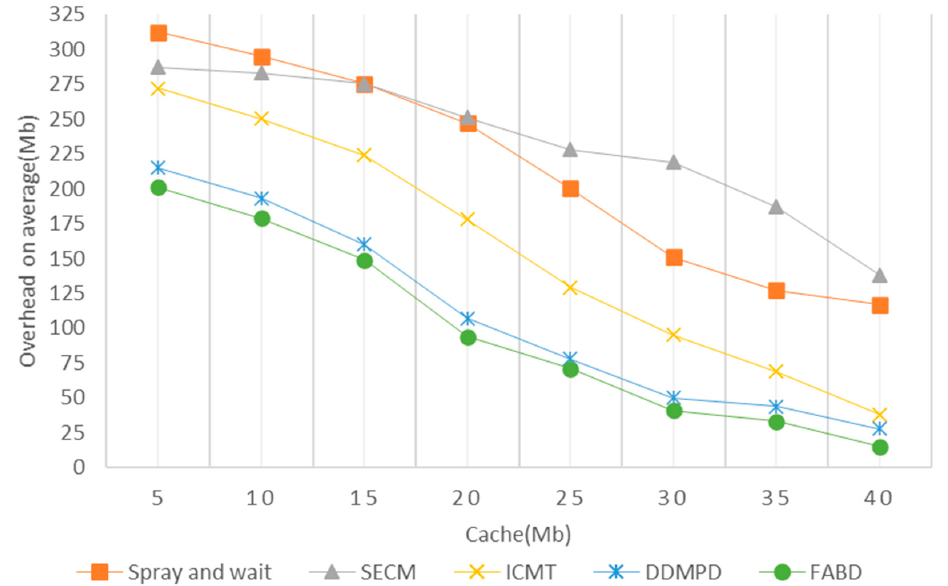
Figure 9. The relationship between routing overhead and cache.